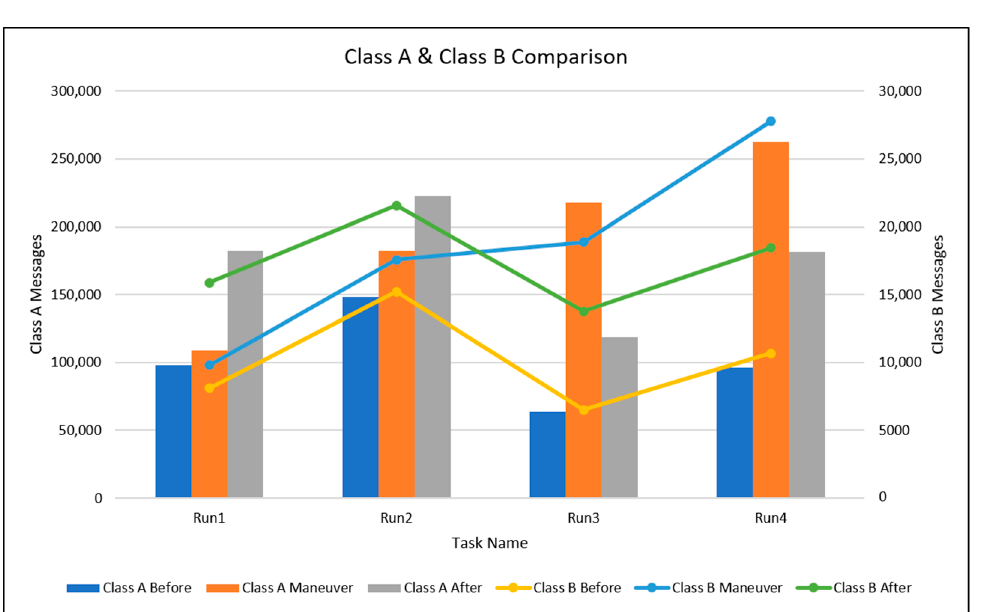
Figure 13. Comparison of the number of received class A & B messages for each observation.